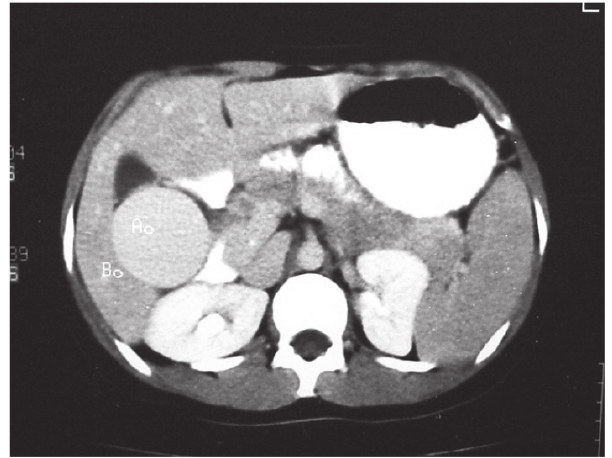
Figure 1 - Computed tomography showing a portal vein dilation measuring 50 mm in diameter in the hepatic hilus. There is no thrombus inside. The spleen has a normal size. Performed in 1998.